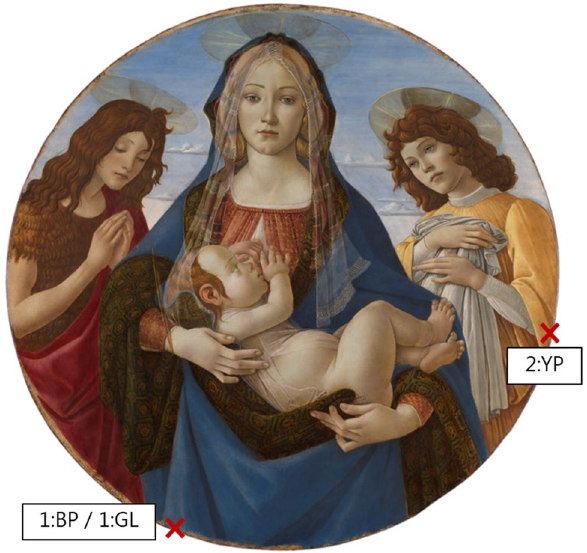
Figure 1. Workshop of Sandro Botticelli. The Virgin and Child with Saint John and an Angel. About 1490. Copyright: The National Gallery, London. The red crosses indicate the two spots where three samples were removed for palaeoproteomic analysis: 1:BP—blue paint of drapery; 1:GL—ground layer directly below sample 1:BP; 2:YP—yellow paint of